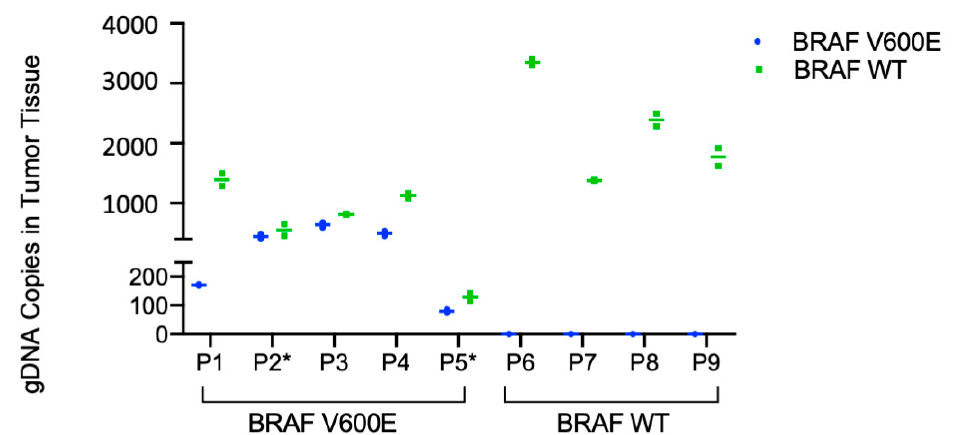
Figure 4. BRAF V600E and BRAF Wild Type ddPCR assay in patient tumor tissue. Absolute quantification of the BRAF V600E and wild type copy number in tumor tissue is plotted as mean +/ − SD against patient study ID, grouped as known BRAF mutant and BRAF wild type as determined by either SNapShot assay or IHC. gDNA was isolated from fresh frozen tumor tissue or FFPE slides (*),